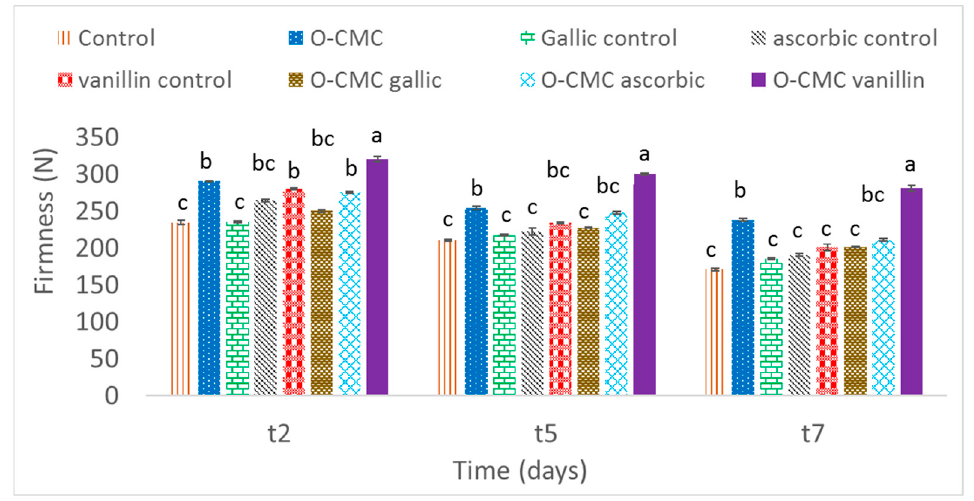
Figure 3. Firmness of fresh strawberries treated with oligo-CMC formulations at three testing times after 2, 5, and 7 days (t2, t5, and t7, respectively) as the means of 5 replicates. Values followed by a different letter within the same sampling time are significantly different according to Tukey HSD test at p ≤ 0.05.